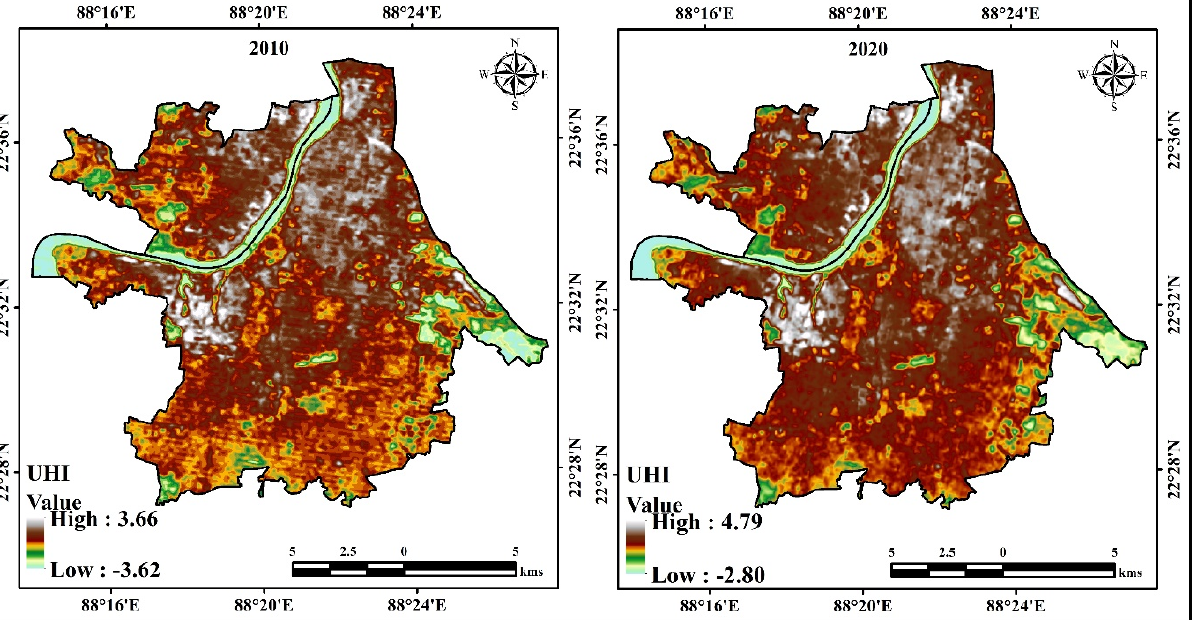
Figure 13. SUHI variation in 2010 and 2020 for West Bengal (Kolkata and Howrah).